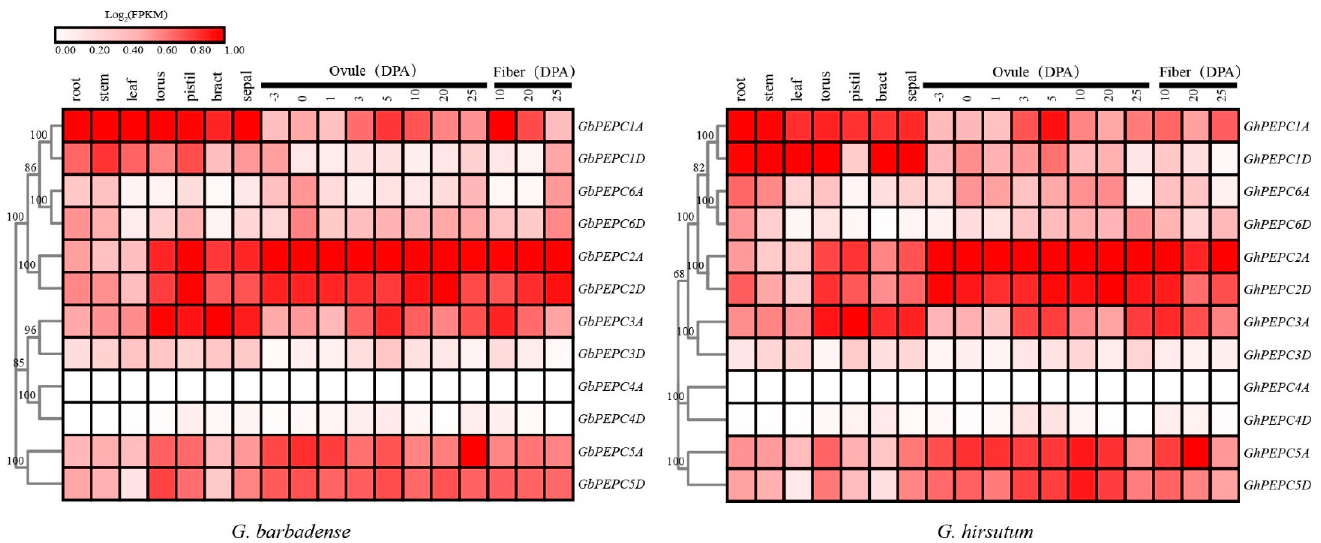
Figure 7. Expression profiles of PEPC genes in different tissues and during different developmental stages of ovule and fiber.